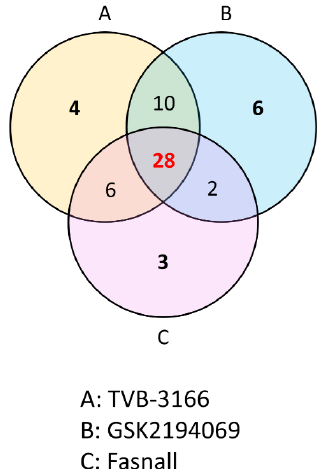
Figure 3. Venn diagram comparison analysis. An overlap of the common metabolites of the TVB-3166 (group A), GSK2194069 (group B), and Fasnall (group C) from the metabolite analysis.